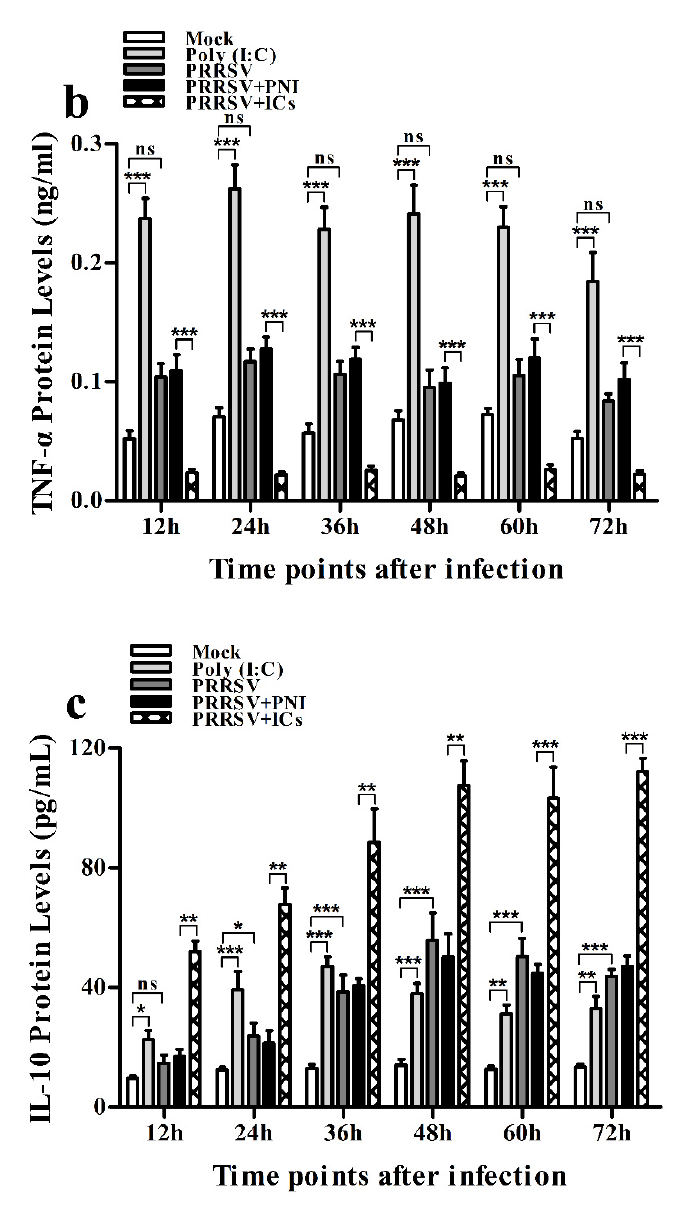
Figure 3. Effect of PRRSV infection or PRRSV-ADE infection on protein expression of cytokines in porcine AMs. Cytokine protein levels in culture supernatants of mock cells, poly (I:C)-stimulated cells, PRRSV-infected cells, PRRSV + PNI-infected cells or PRRSV + ICs-infected cells were detected by using ELISA Kits. ( a ) IFN- α protein level, ( b ) TNF- α protein level, ( c ) IL-10 protein level. *** p < 0.001, ** p < 0.01, * p < 0.05, ns: no significance. Note: PRRSV + PNI: PRRSV + porcine-negative IgG; PRRSV + ICs: PRRSV + porcine IgG against PRRSV; PRRSV-ADE: antibody-dependent enhancement of PRRSV.